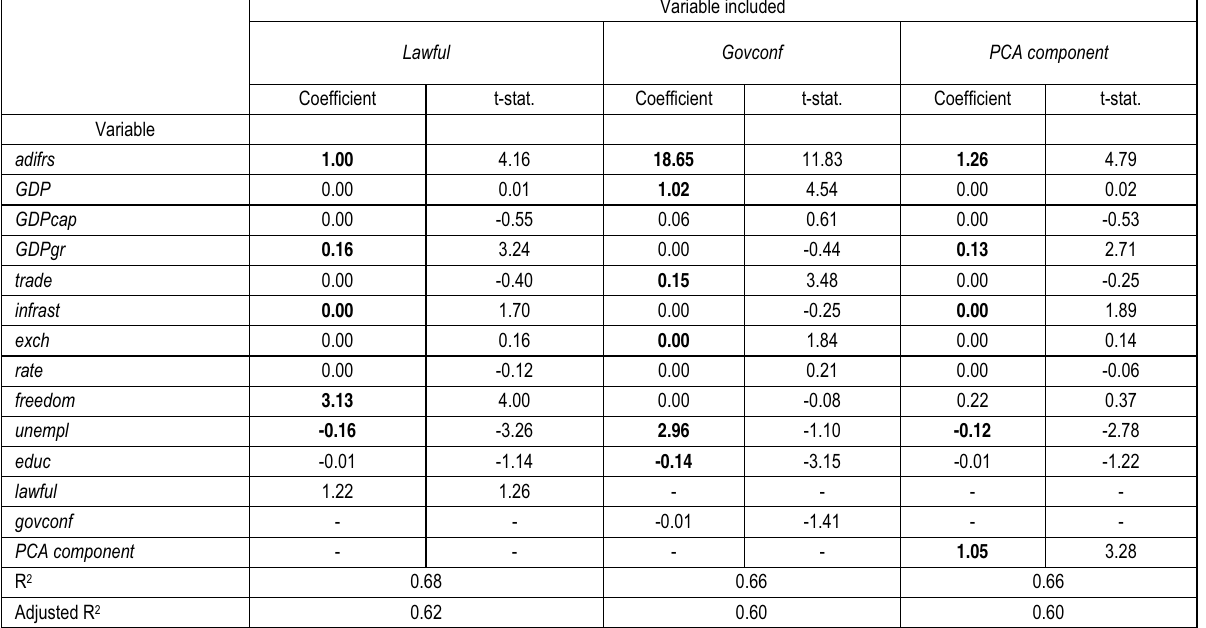
Table 4. Robustness checks-developed